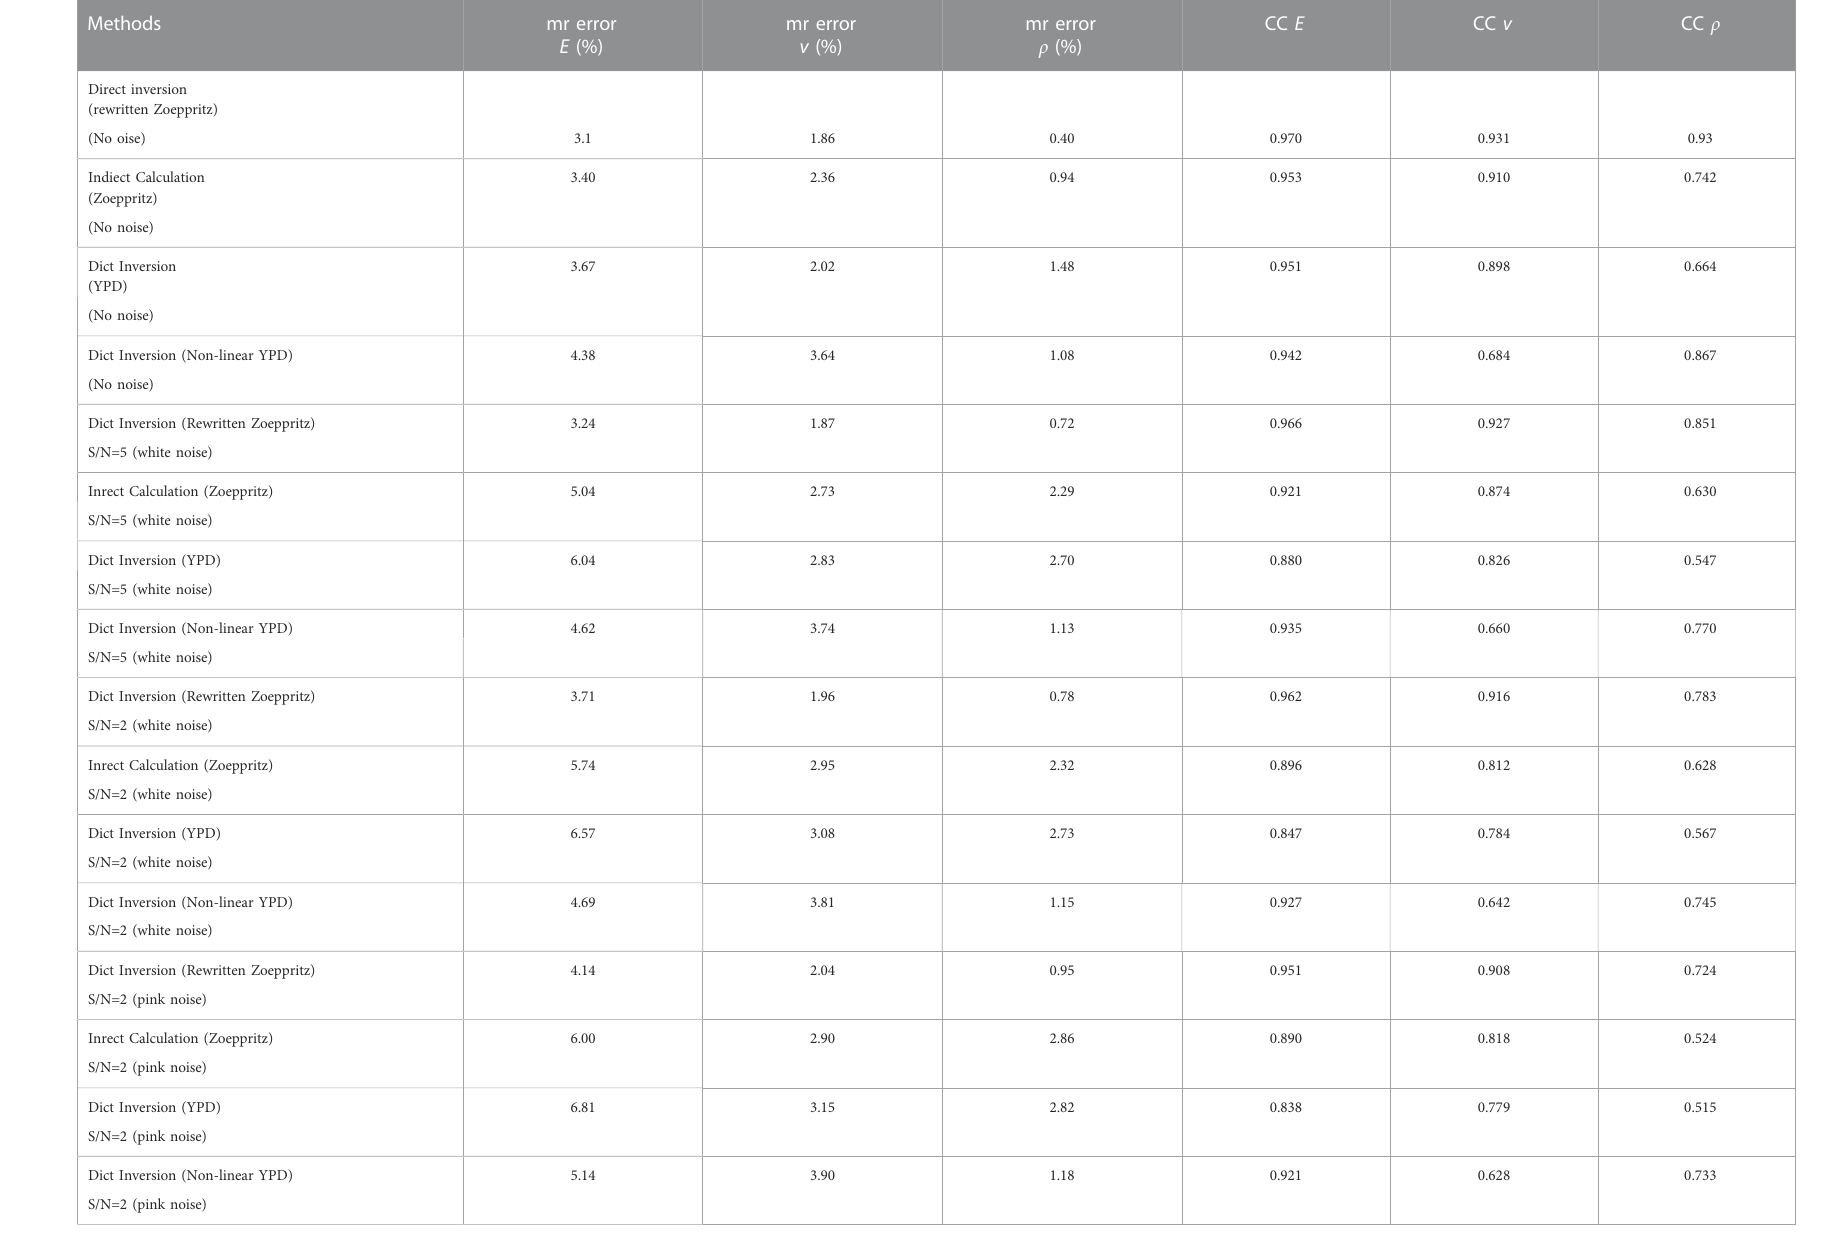
TABLE 4 The mr error and CC between the true models and the estimation results of E, v, and ρ , respectively, for different methods and S/Ns.